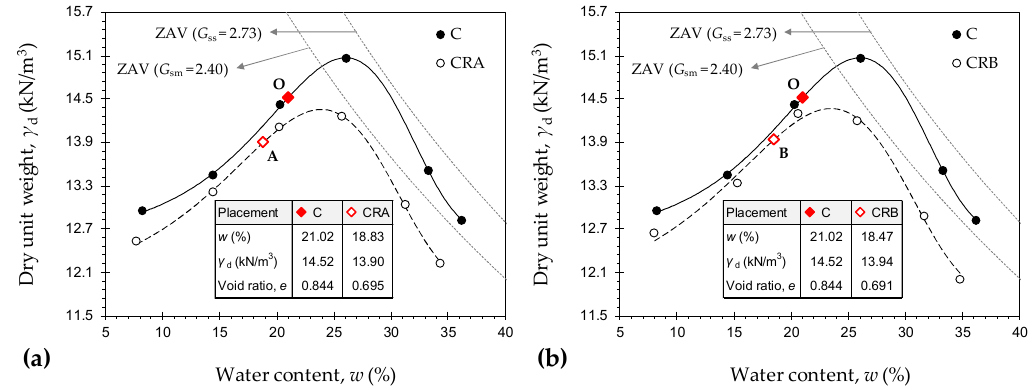
Figure 2. Standard Proctor compaction curves for the tested mix designs (ZAV is zero air voids): ( a ) C and CRA; and ( b ) C and CRB.